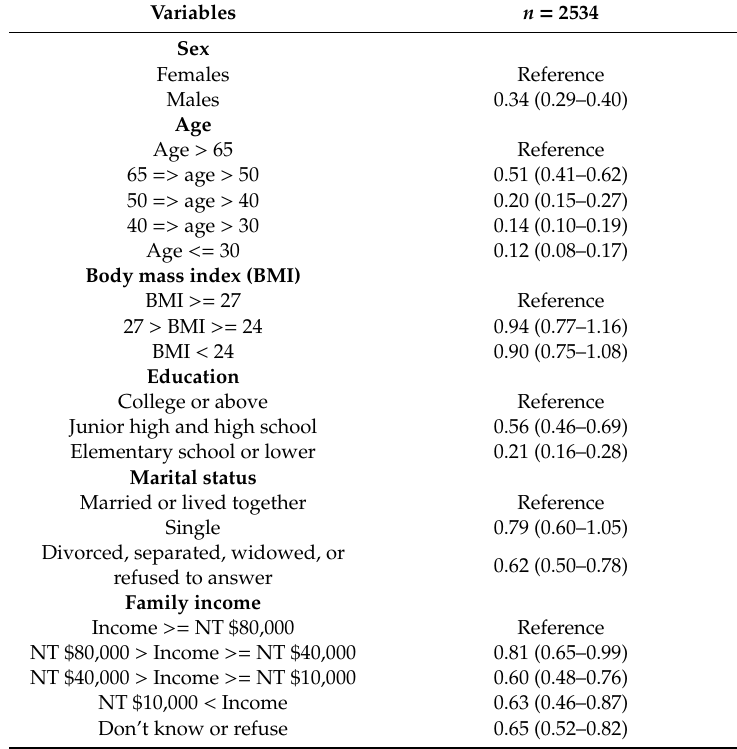
Table 5. The associations between levels of adherence to overall daily food guides and demographic characteristics. Variables n =